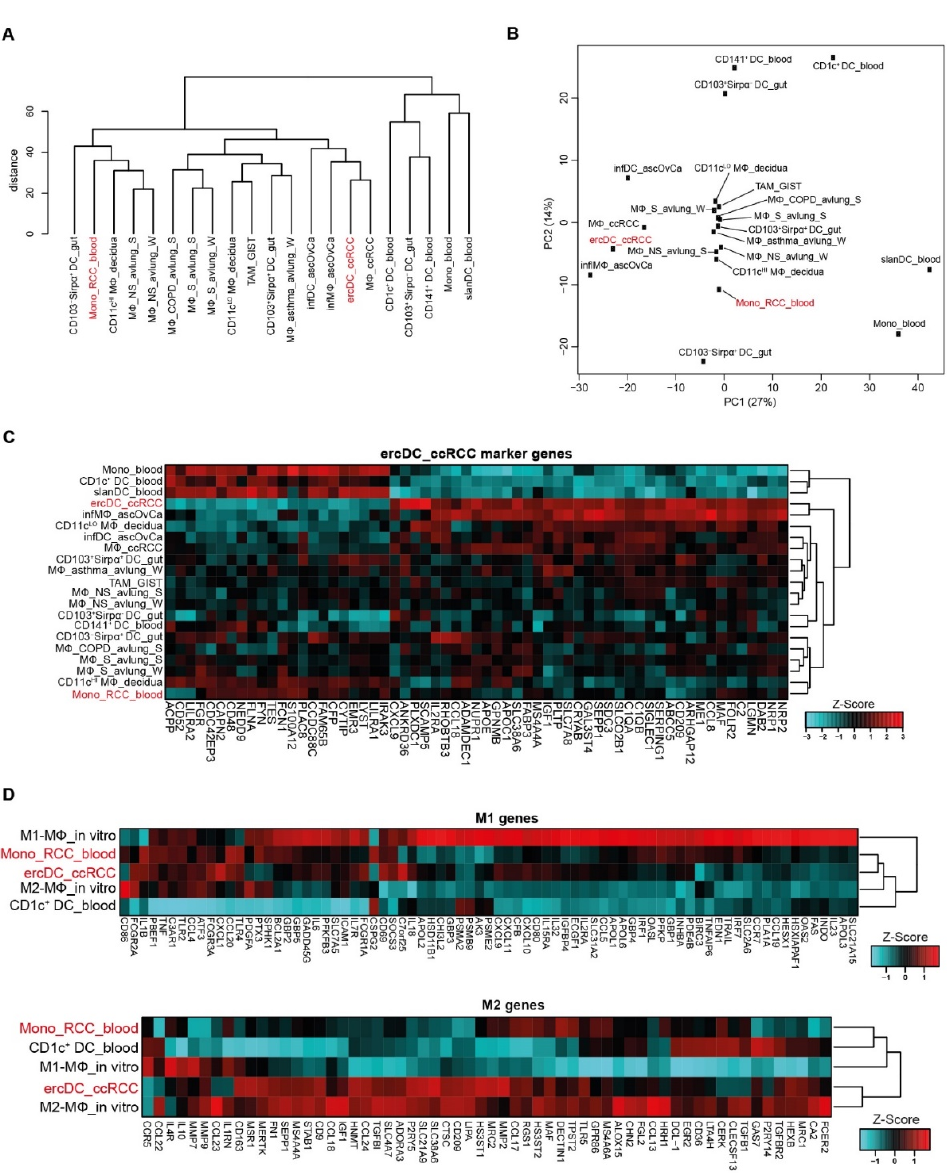
Figure 6. Transcriptome comparison of ercDC_ccRCC with published blood monocytes from RCC patients. All figures are based on expression levels with blood-specific genes not excluded. See Figure S3 for results after exclusion of blood-specific genes. ( A ) Hierarchical clustering and ( B ) PCA of gene expression profiles. Analyses are based on informative genes for which the median expression value of replicates for each cell type was calculated. ( C ) Clustered heatmap of ercDC_ccRCC marker genes with blood monocytes of RCC patients (Mono_RCC_blood). ( D ) Clustered heatmaps showing relative expression levels of genes associated with M1- and M2-macrophages in Mono_RCC_blood and